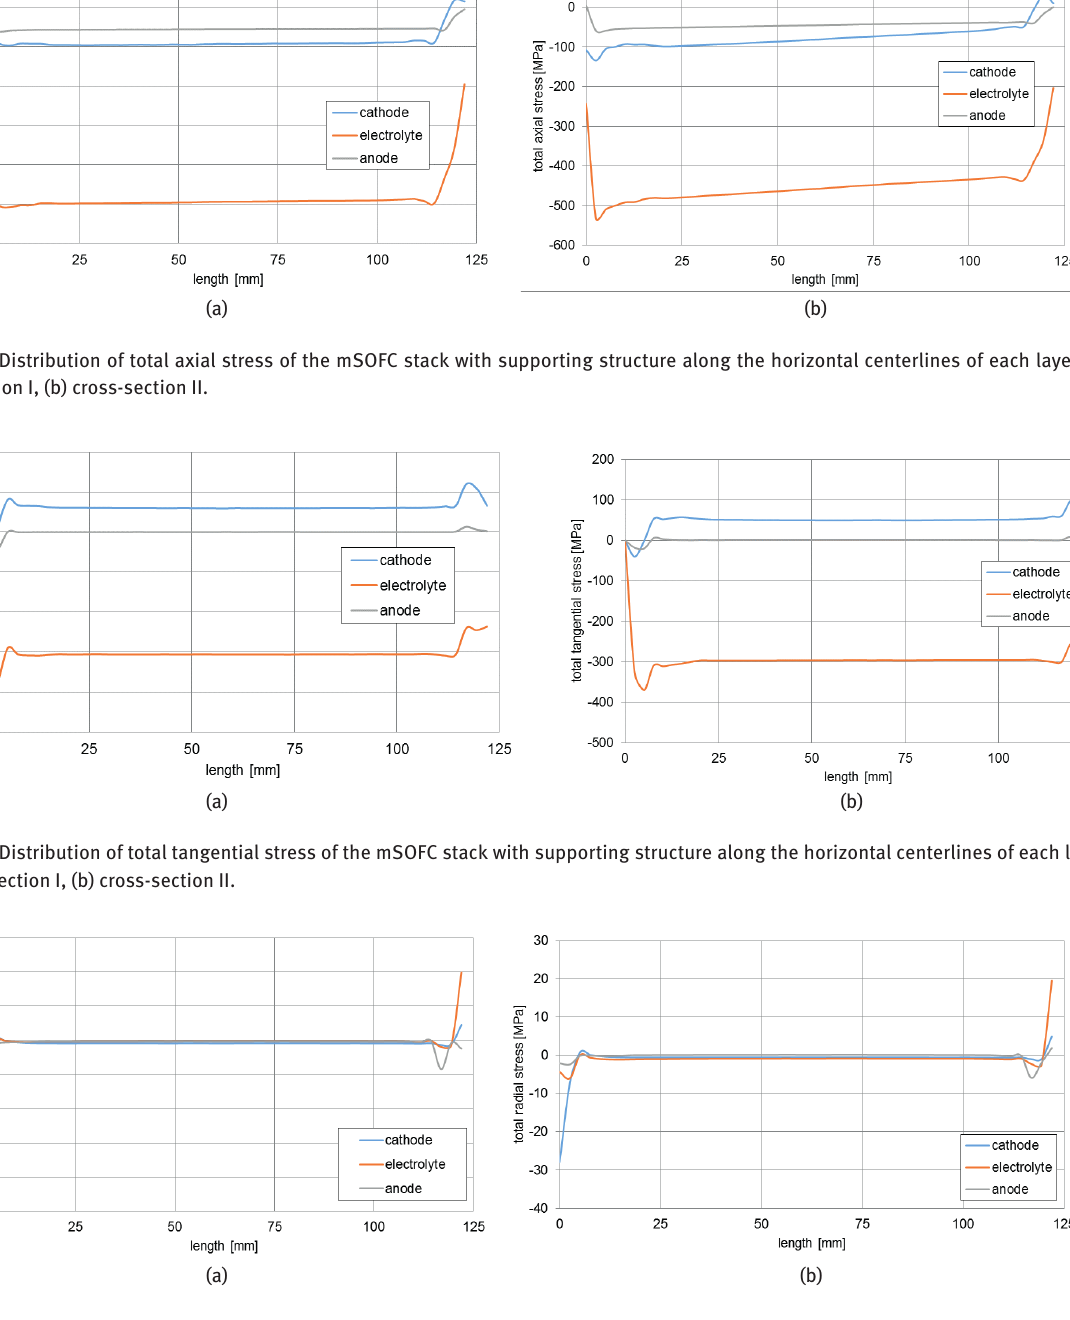
Figure 19: Distribution of total radial stress of the mSOFC stack with supporting structure along the horizontal centerlines of each layer: (a) cross-section I, (b) cross-section